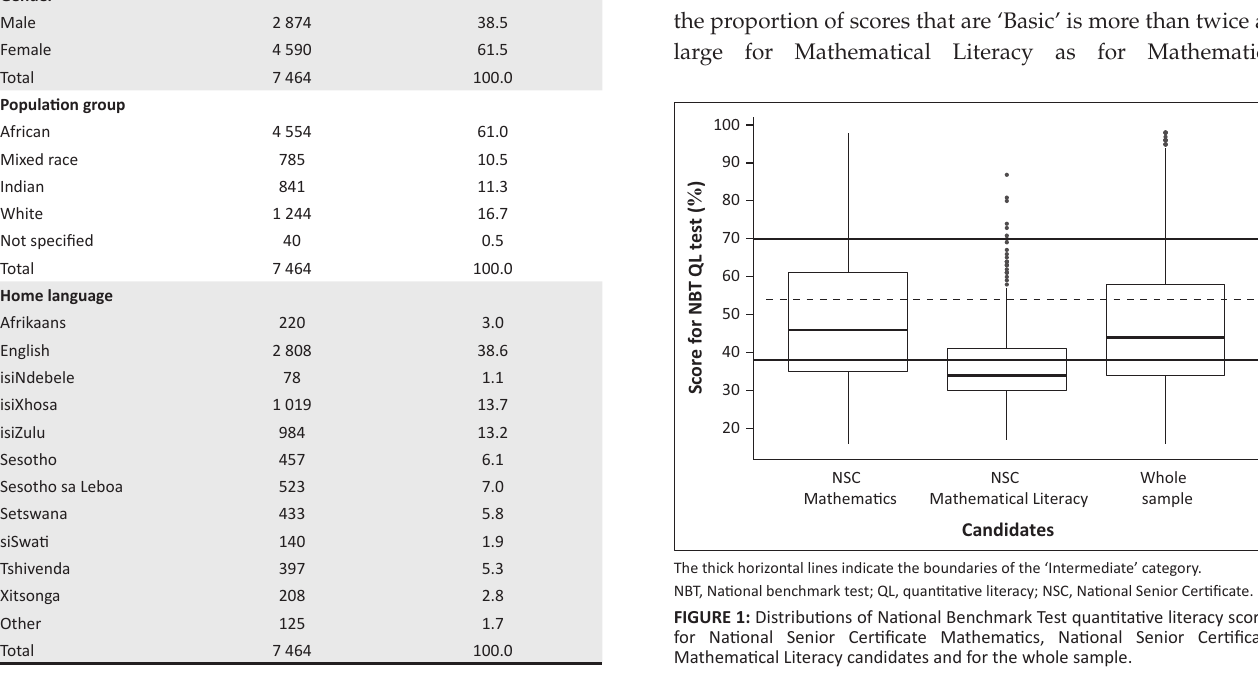
TABLE 6: Descriptive statistics for the distributions of the quantitative literacy performance of the whole sample ( N = 7 464) and of subsets defined by National Senior Certificate mathematics subject written. Variable